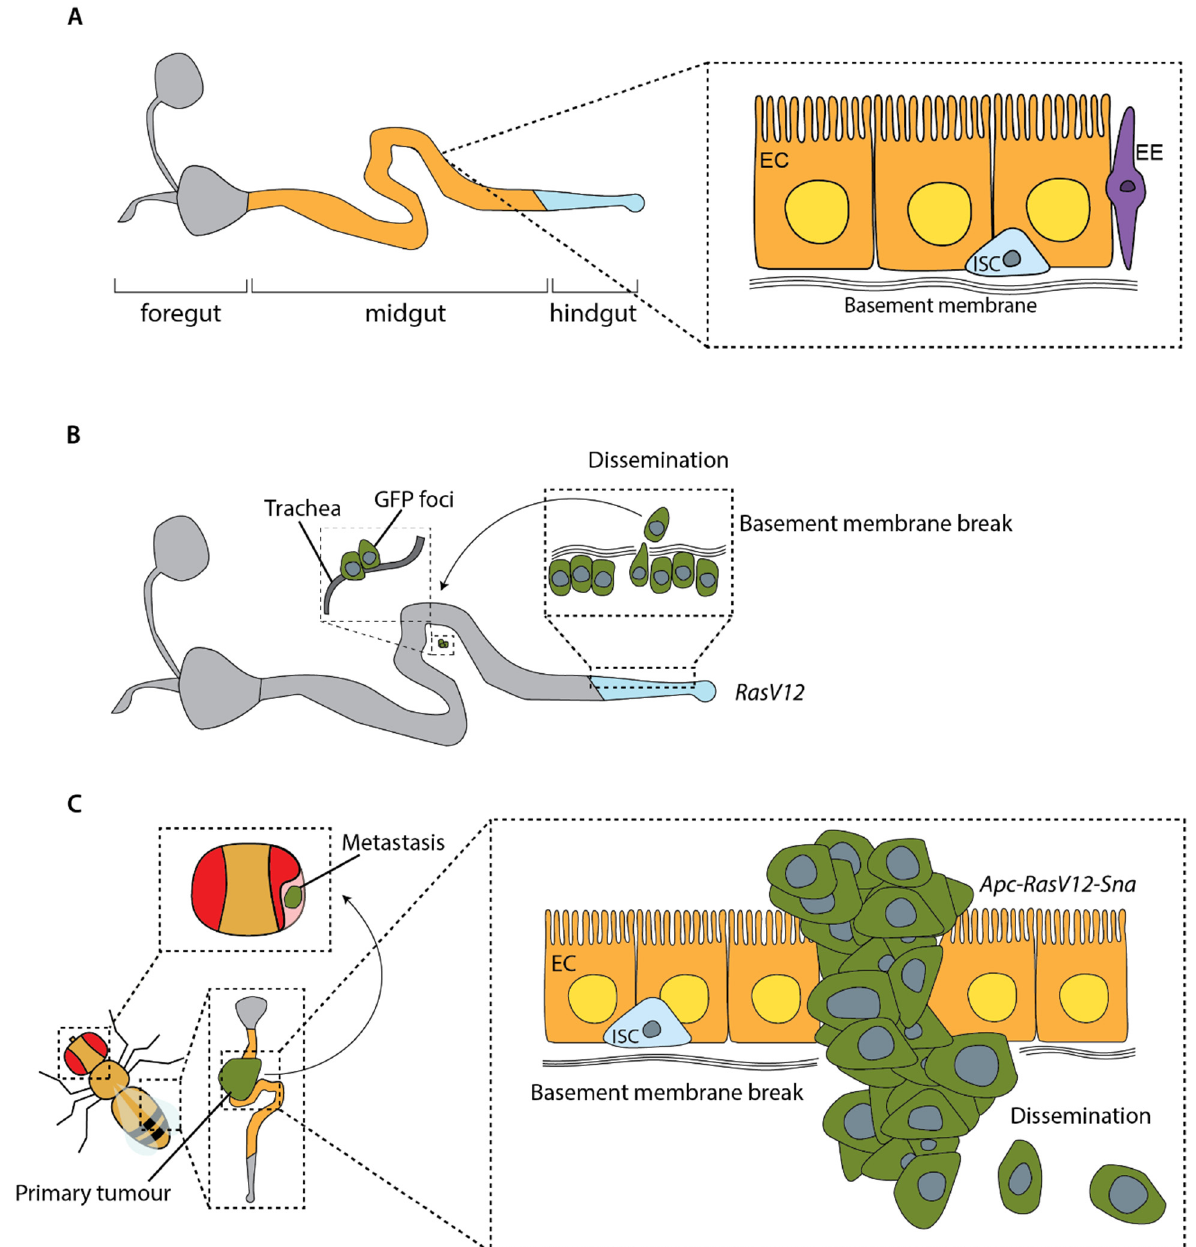
Figure 5. Modelling metastasis in adult flies. ( A ) The adult midgut contains pools of intestinal stem cells (ISCs) under constant renewal, which has enabled the development of adult cancer models. EC = enterocyte; EE = enteroendocrine cell. ( B ) Cells expressing Ras V12 in enterocytes and their progenitors in the hindgut can disrupt the basal lamina to invade out of the hindgut and can be found individually or in clusters in the midgut and associated with trachea [96]. ( C ) Overexpression of the EMT transcription factor Snail in Apc-Ras V12 flies enables tumour cells to break through the basement membrane, disseminate and form secondary tumours. These can be seen in the thorax and the head